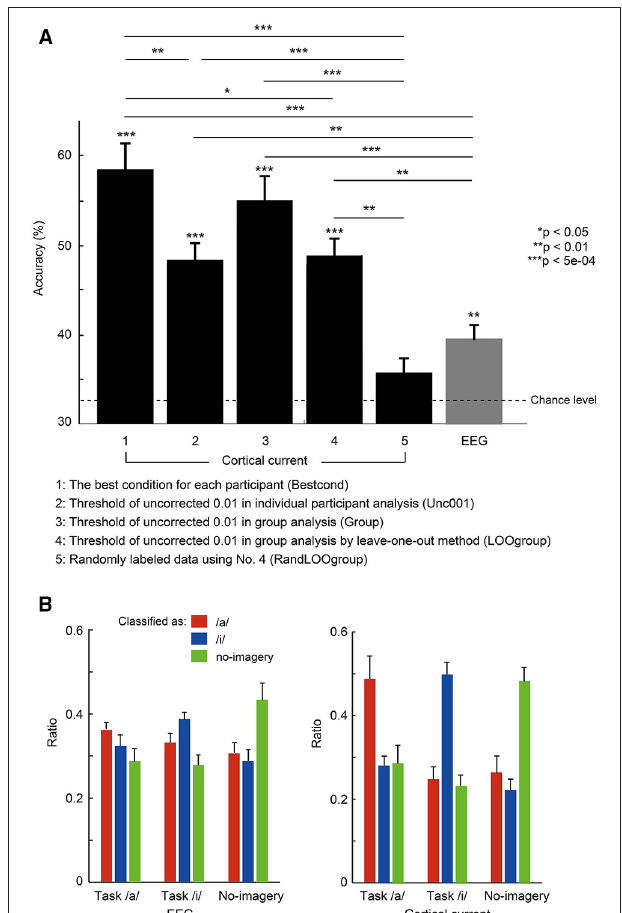
FIGURE 4 | (A) Mean accuracies averaged across 10 participants for the three-class classification using EEG sensor and cortical current data. Error bars denote standard error. The dotted line denotes chance level of 33.3%. * p < 0 .05, ** p < 0 .01, *** p < 5 e-04 usnig non-parametric permutation tests. Parameters used for each condition (No. 1–No. 5) are shown in Table 1 . (B) Comparison of classification output ratio for each task resulting from EEG sensor ( left ) and cortical current ( right ) classification. Using a probability map from each classification analysis, the number of times that marked the highest probability was counted for each task. Then the ratio of that number to the total number of cross-validations was calculated and averaged across participants. For each task, red bars represent the ratio classified as vowel /a/, blue bars as vowel /i/, and green bars as no-imagery.